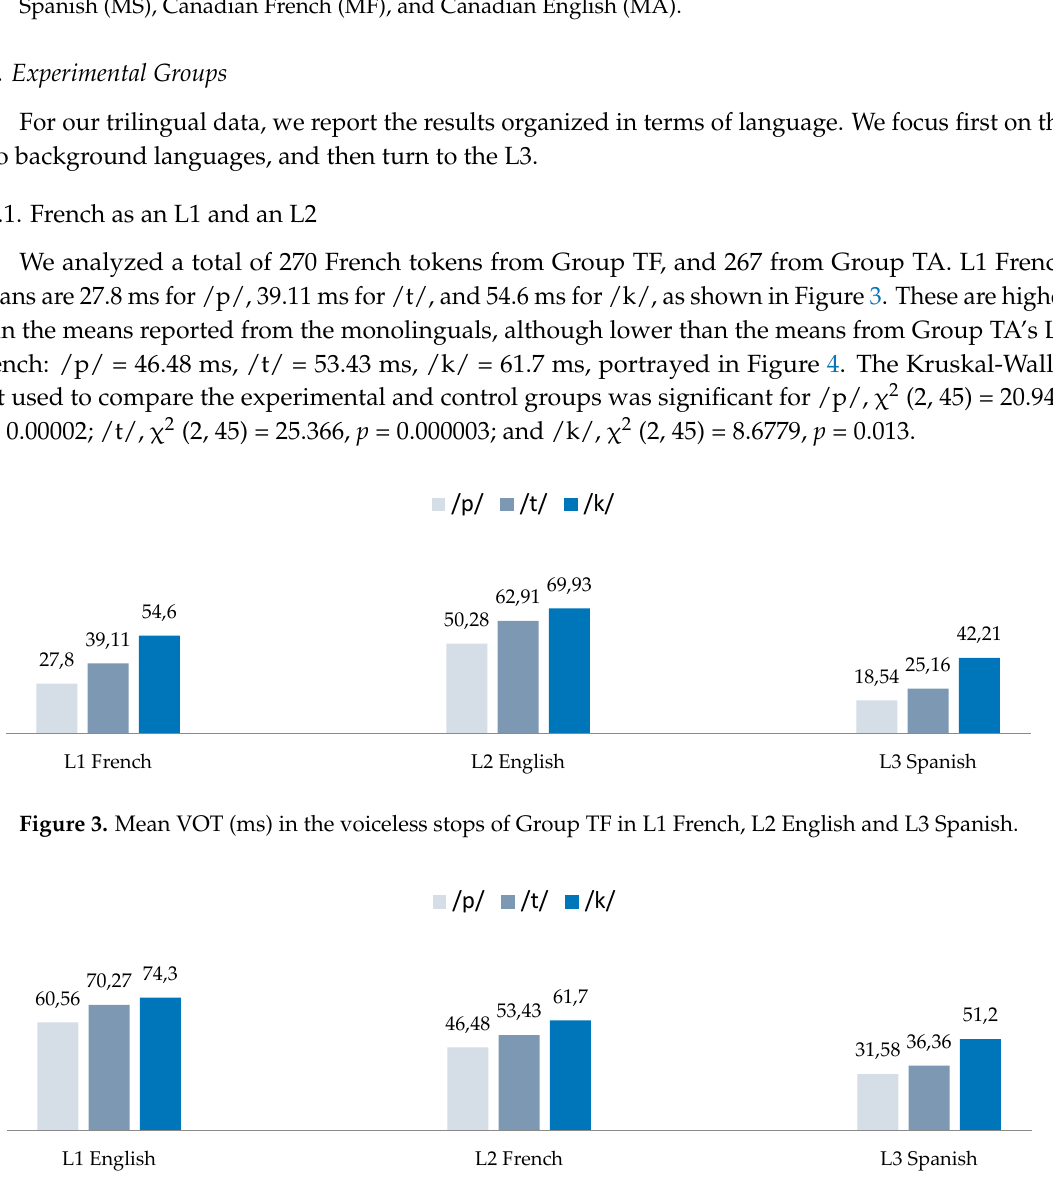
Figure 4. Mean VOT (ms) in the voiceless stops of Group TA in L1 English, L2 French and L3 Spanish.